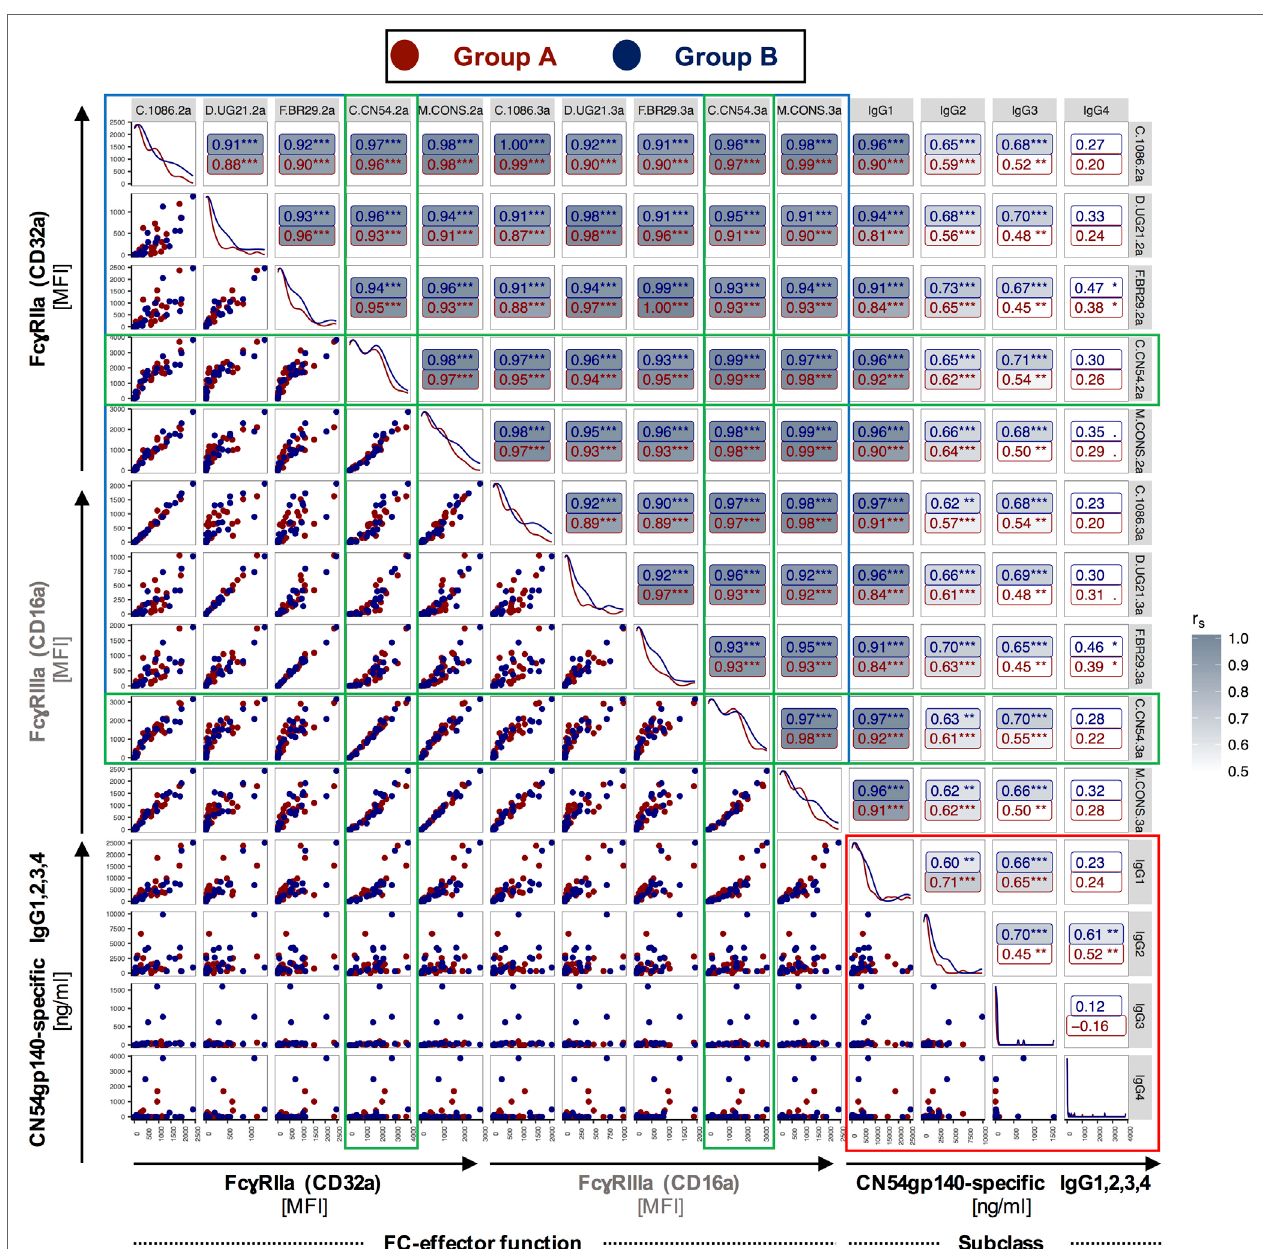
FiGUre 6 | Correlations between Cn54gp140-specific igG subclass measurements and Fc γ riia (CD32a)/Fc γ riiia (CD16a) binding profiles for Group a and B . A customized multiplex assay was used to determine binding of dimerized Fc γ RIIa or Fc γ RIII following binding to different human immunodeficiency virus (HIV)-clade proteins in serum samples from Group A and B. For simplicity, the horizontal and vertical labels, indicating the various HIV-clade proteins, were labeled with the ending .2a or .3a, respectively, to designate Fc γ R dimers. Correlations between CN54gp140-specific IgG subclasses are boxed in red, and correlations between Fc γ RIIa/Fc γ RIIIa binding profiles are boxed in blue, while correlations directly related to the CN54gp140 antigen, which was used for serial immunizations, are boxed in green. C.CN54gp140-mediated engagement of both Fc γ RII- and Fc γ RIIIa-receptors was positively associated with CN54gp140-specific IgG1/2 in both groups. Both study groups exhibit identical isotypic and Fc γ R-binding profiles. r S —Spearman’s rank correlation coefficient (* p < 0.05, ** p < 0.01, *** p <